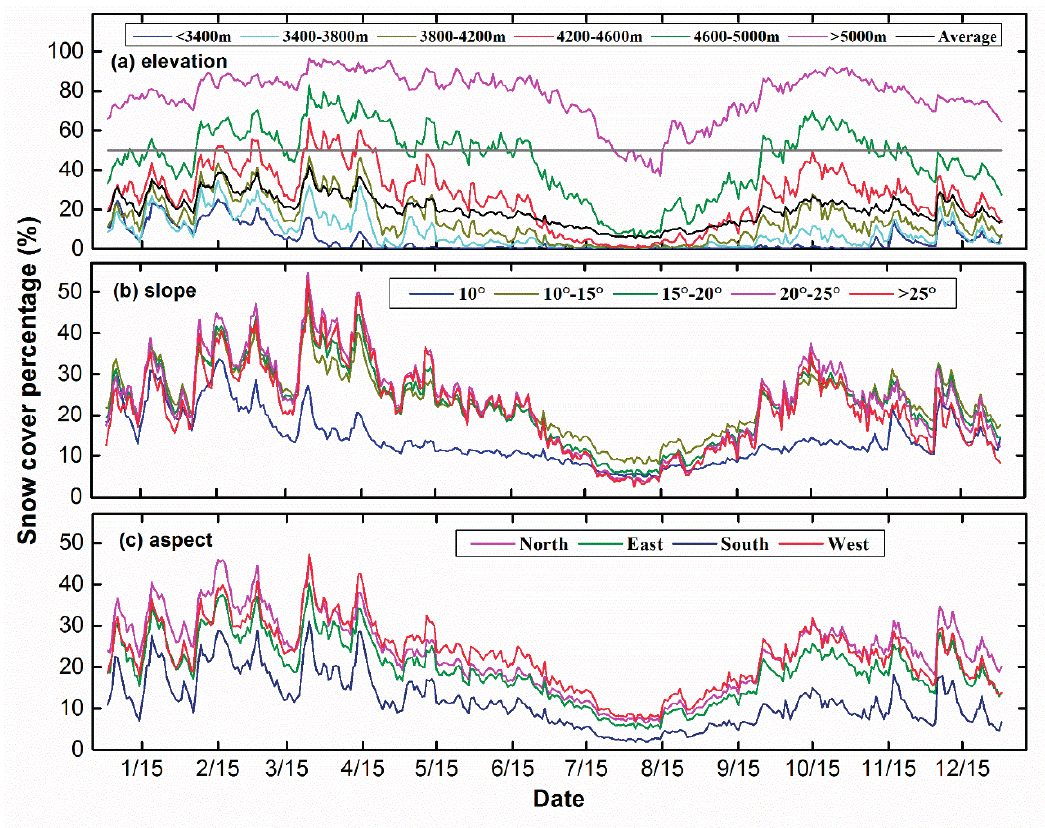
Figure 4. Mean daily SCP in ( a ) elevation, ( b ) slope, and ( c ) aspect zones during 10 hydrological years from October 2002 to September 2012. The gray solid line in (a) denotes a SCP of